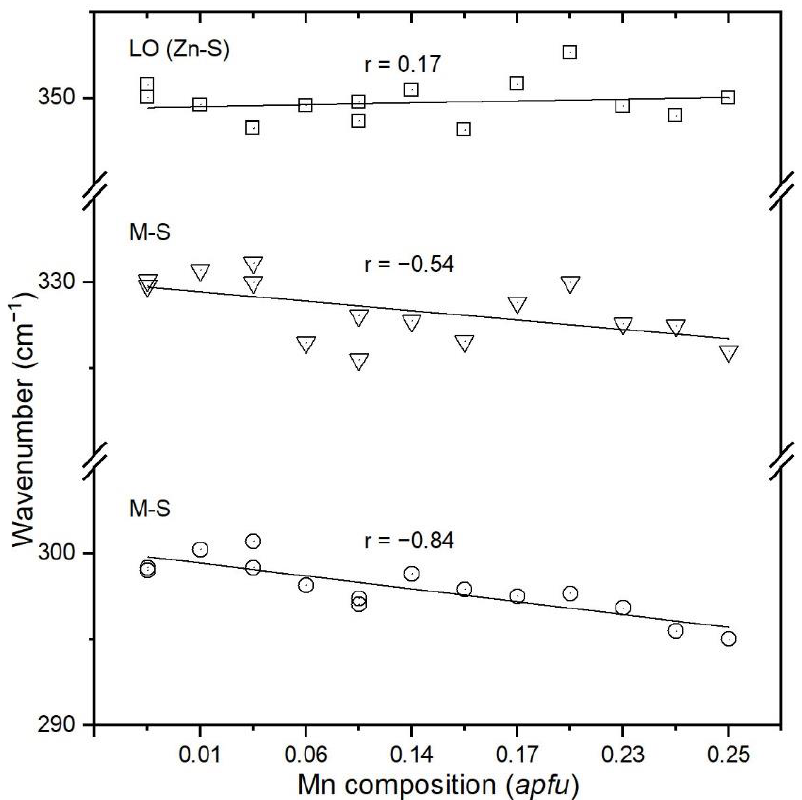
Figure 6. Correlation between Raman bands position (cm −1 ) and the Mn composition ( apfu ) of the sphalerite from the Săcărâmb ore dep osit.